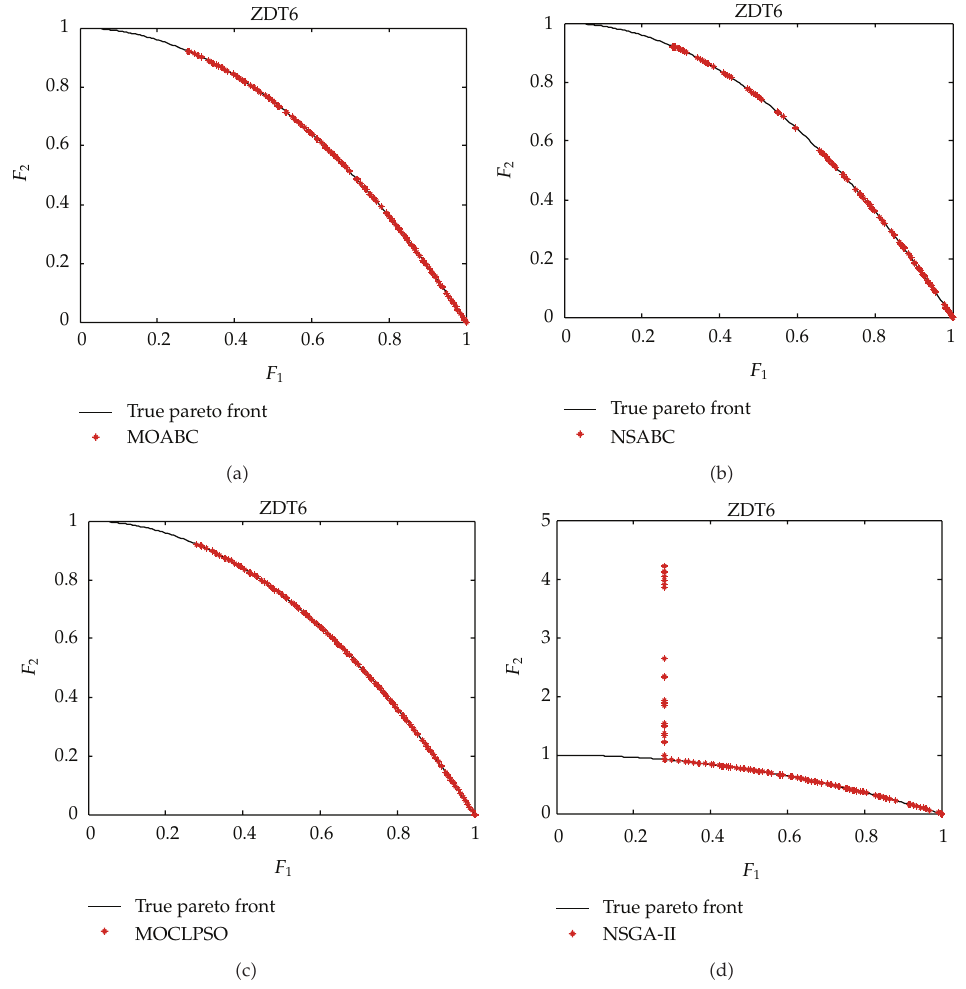
Figure 12: Pareto fronts obtained by NSABC, MOABC, MOCLPSO, and NSGA-II on ZDT6 after 20000 FEs.